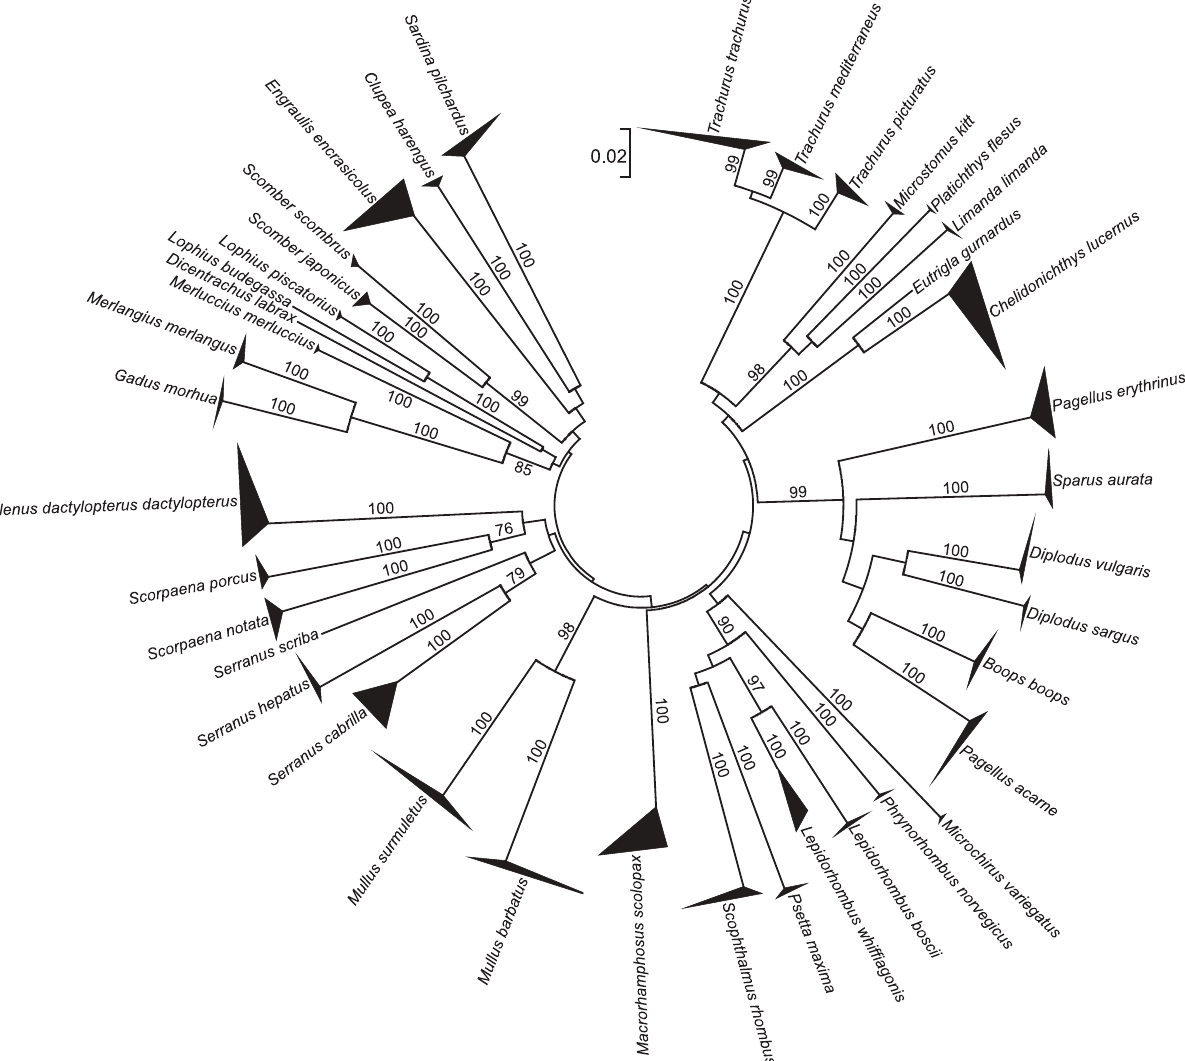
Figure 4. Phylogenetic analysis (cyt b ). Neighbour Joining tree for partial sequences of the mitochondrial cytochrome b gene of fishes from European seas. The number of sequences and their geographic origin for each species are given in Table 1 and Supporting Information Table S1. Bootstrap values based on 1000 replicates are indicated at branches.